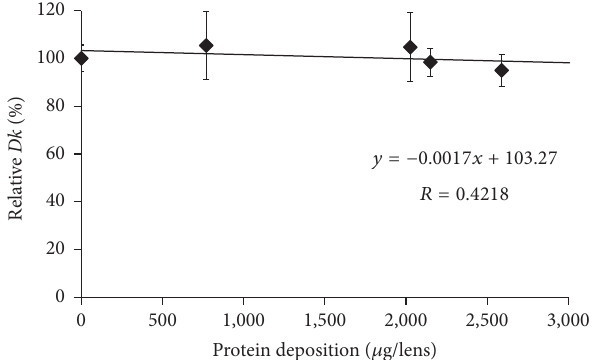
Figure 5: Relationship between relative Dk and amount of protein deposition on balafilcon A